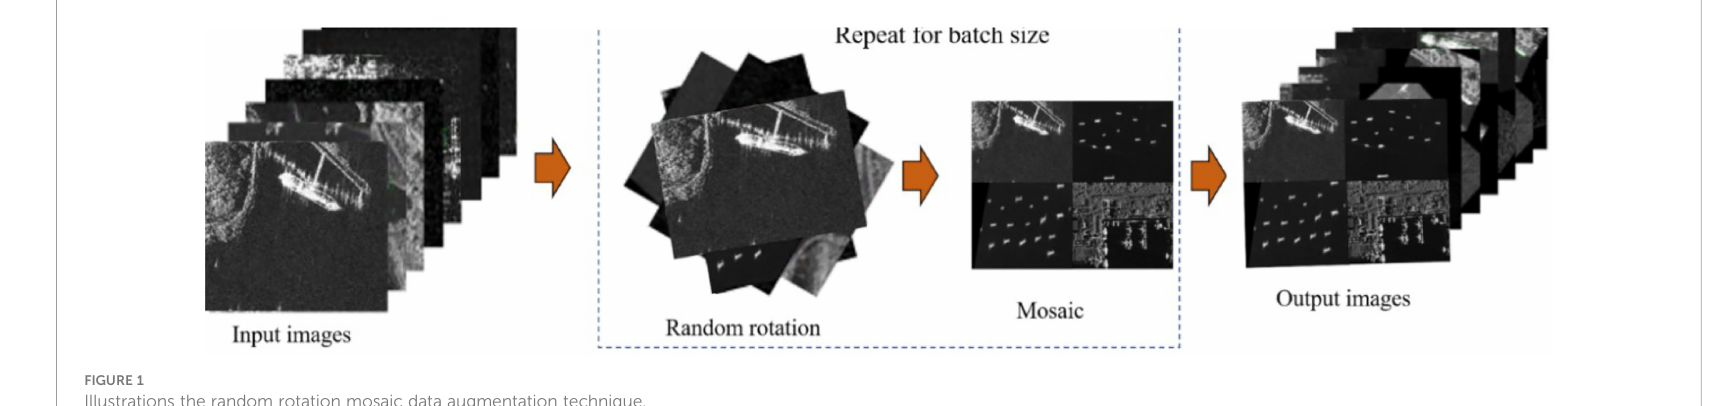
FIGURE 1 Illustrations the random rotation mosaic data augmentation technique.